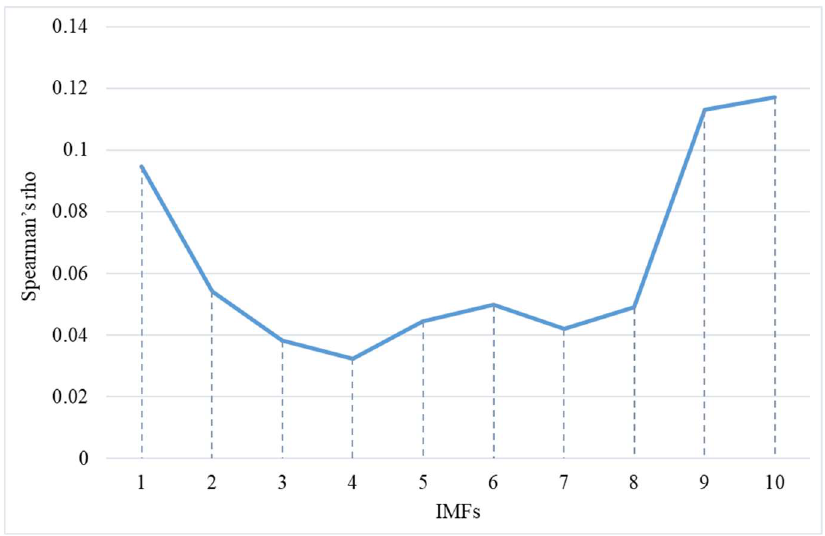
Figure 9. Spearman’s rho of each decomposed IMF.